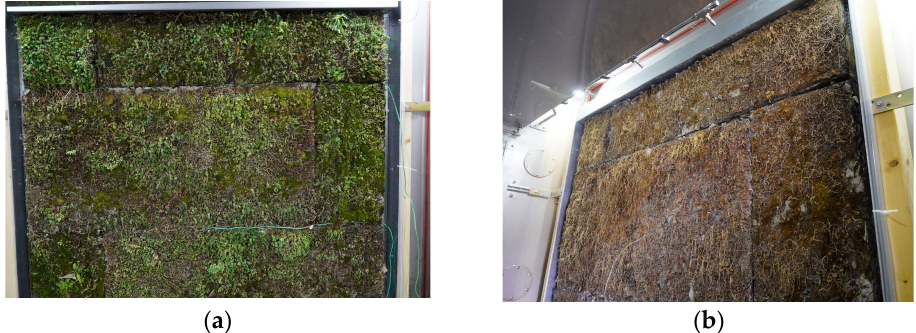
Figure 2. View of the outer skin before ( a ) and after the measurement ( b ). Despite heavy watering at the end, the vegetation was very dry, which was caused by the simulated solar radiation (simulated steady-state test, which is not presented in this paper) and water pump failure.